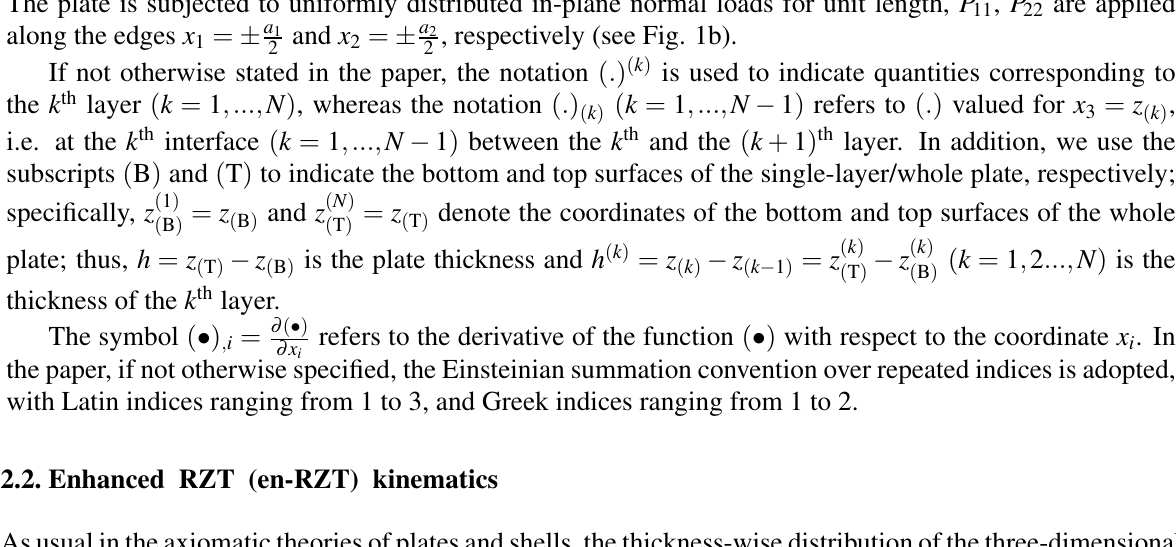
Fig. 1. General plate notation: (a) plate geometry and coordinate system and layer numbering, (b) in-plane loads